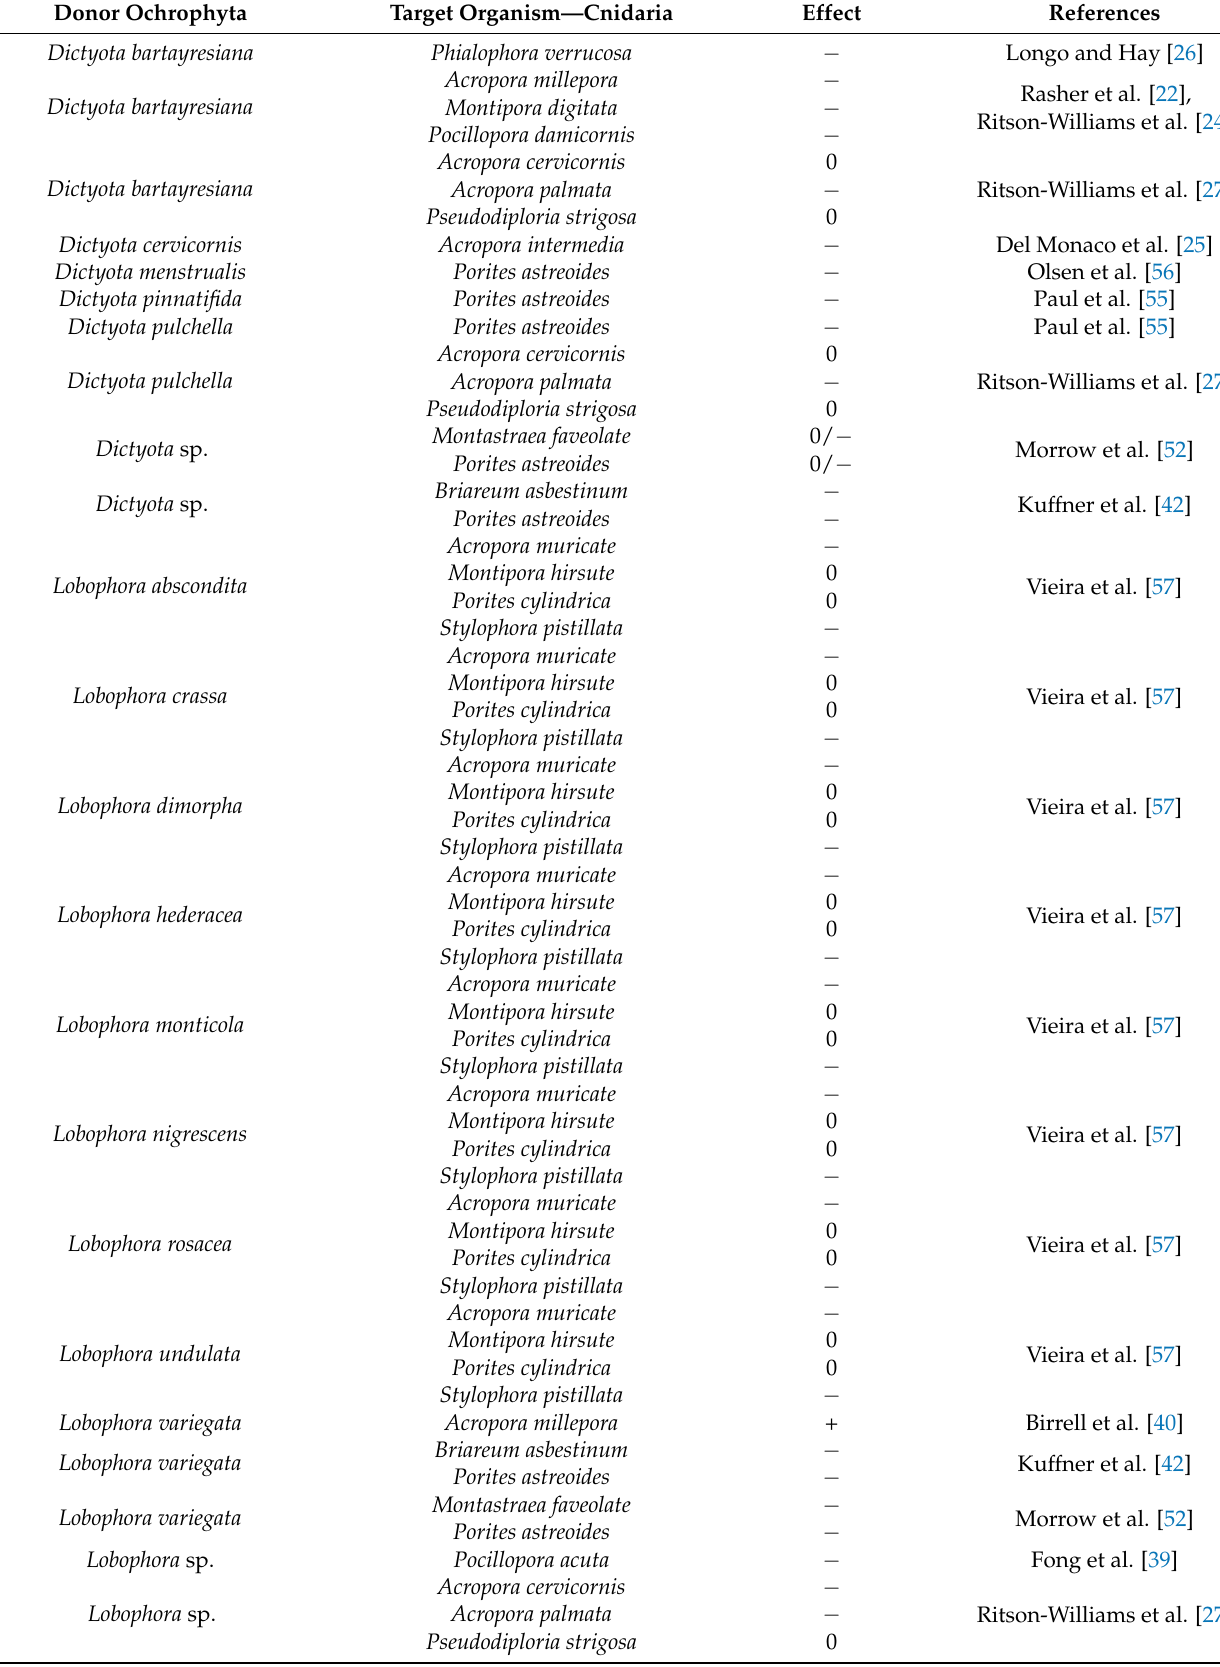
Table 3. Examples of allelopathic activity of brown algae against competitors and